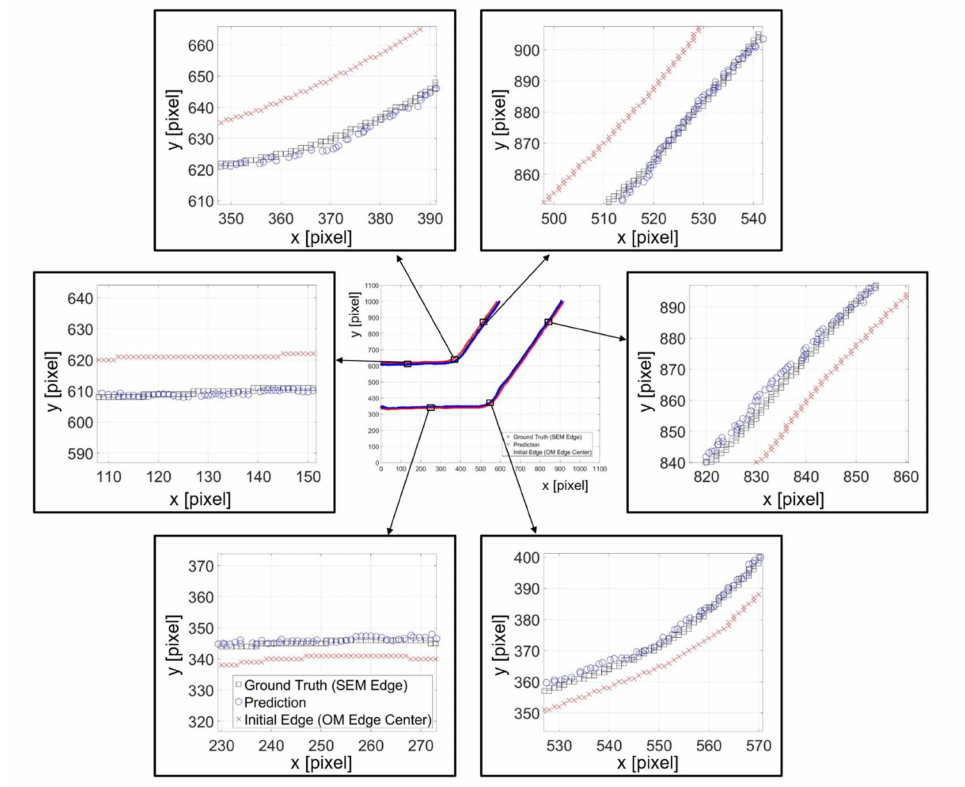
Figure 12. Examples of predicted edge position and the ground truth position from SEM images.